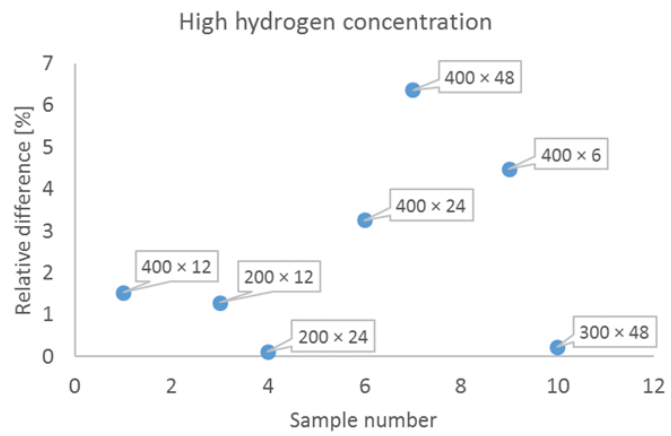
Figure 5. Relative difference between the estimated initial hydrogen concentration in the high-concentration samples and the concentration measured after the heat treatment.